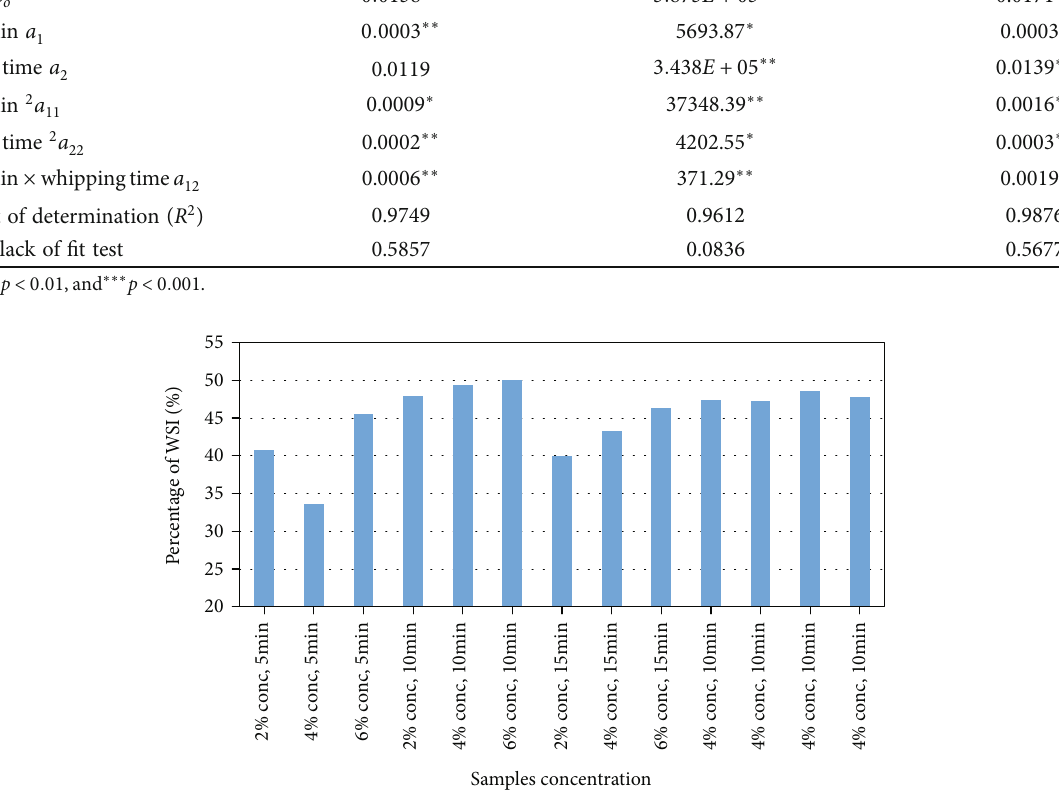
Figure 2: Water solubility index of the